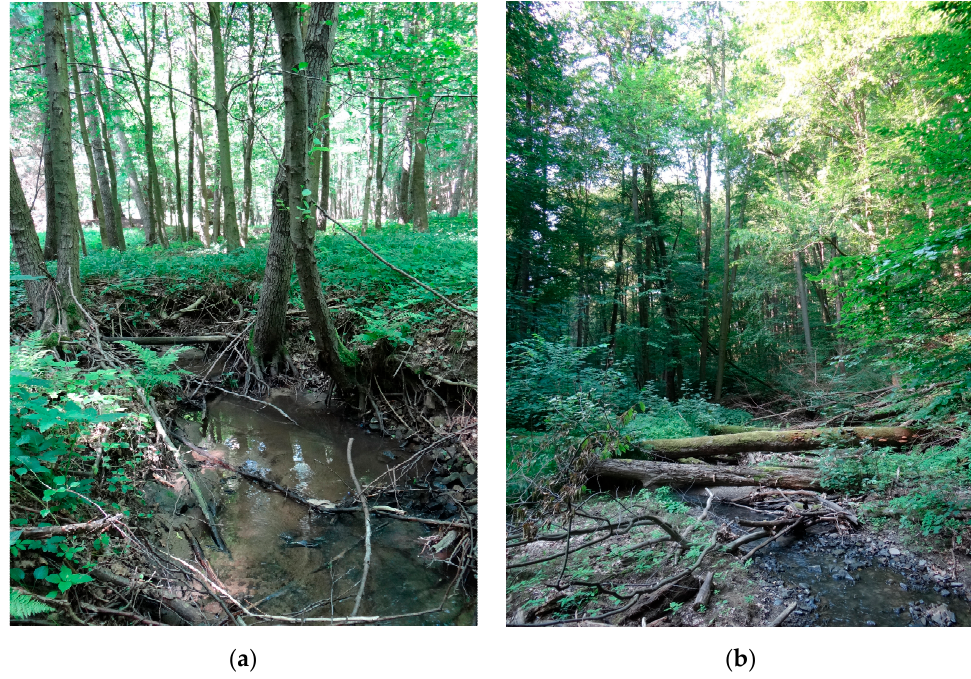
Figure 6. Floodplain forests on wider alluvium with C. heros, forest management unit 297: ( a ) forest stand with Fraxinus excelsior and Alnus glutinosa; ( b ) forest stand with vertical structure of Acer pseudoplatanus , F. excelsior , A. glutinosa , Fagus sylvatica, and Carpinus betulus .